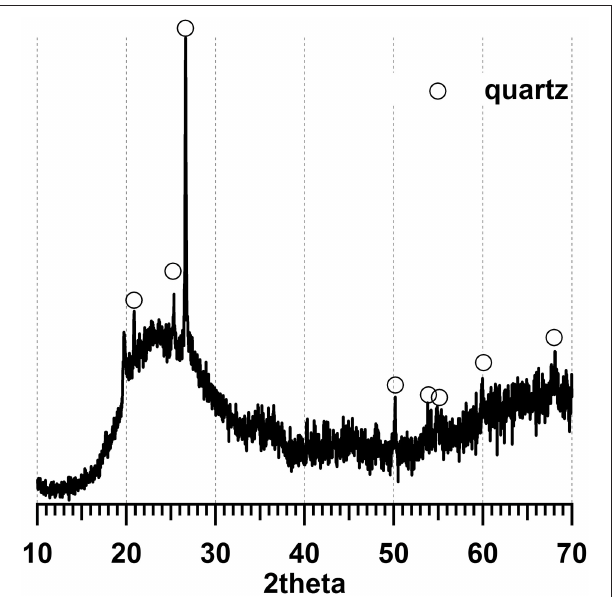
FIGURE 2 | XRD results of MK. The majority of metakaolin is